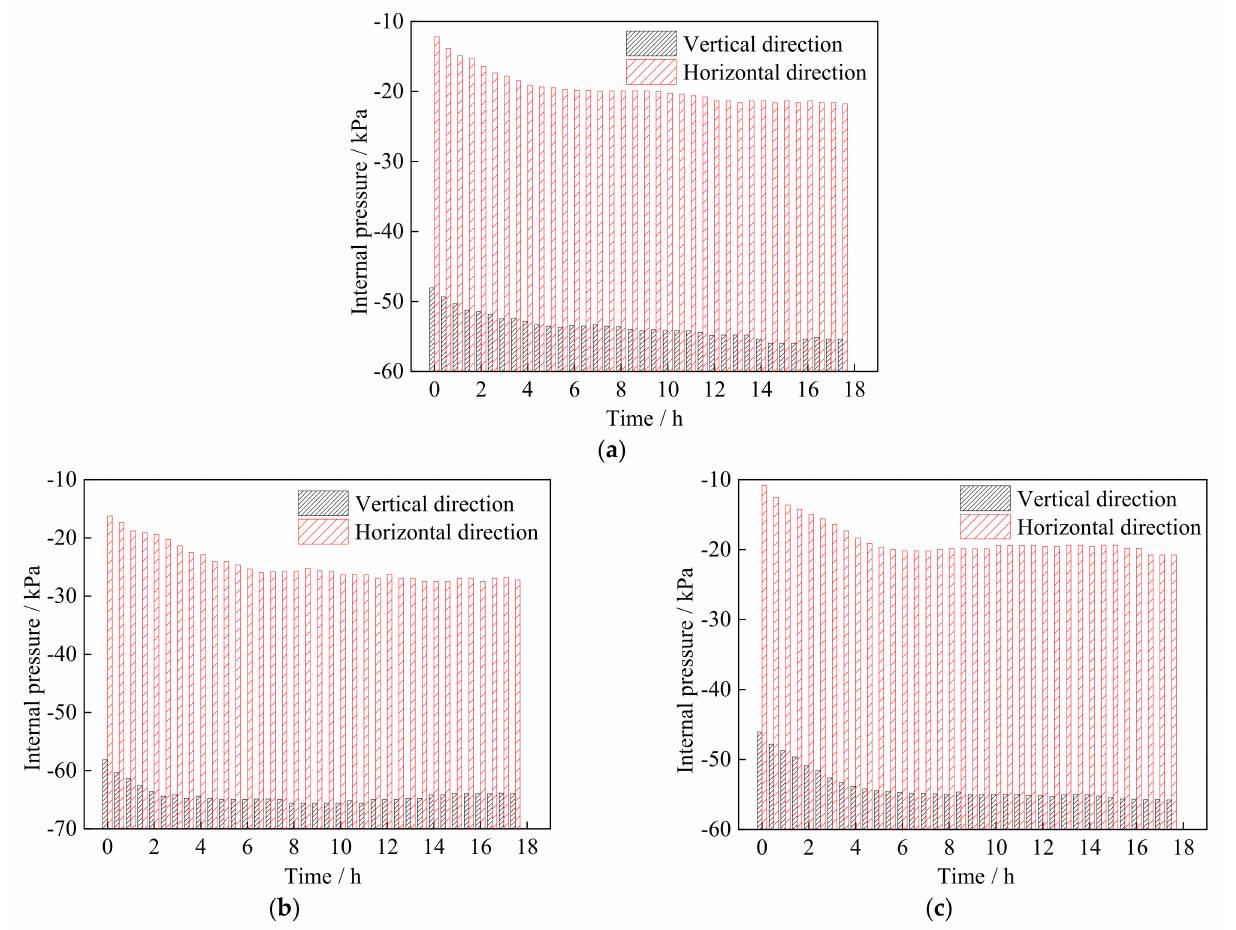
Figure 9. Relationship between pressure in the dam body and time: ( a ) geogrid-reinforced dam, ( b ) conventional dam, and ( c ) geotextile-reinforced